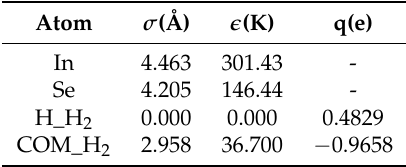
Table 2. A list of force-field parameters used in this